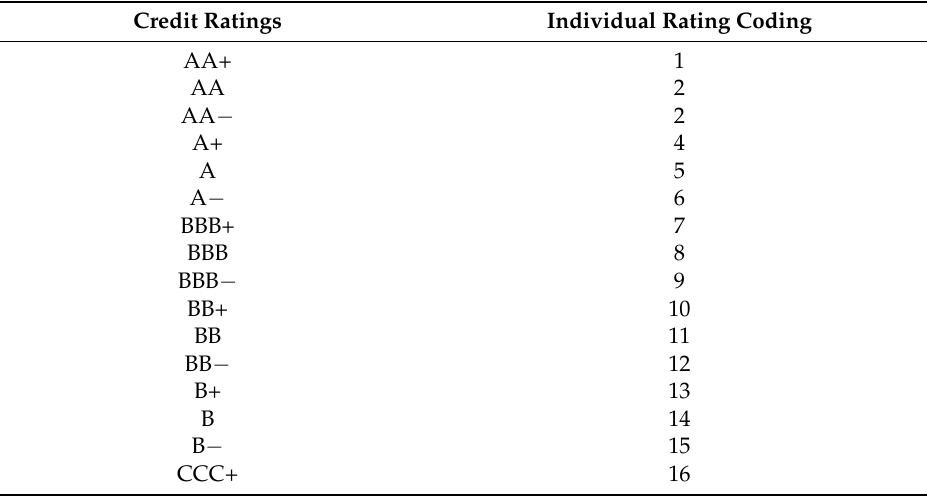
Table 1. Long-term issuer ratings and assigned numerical